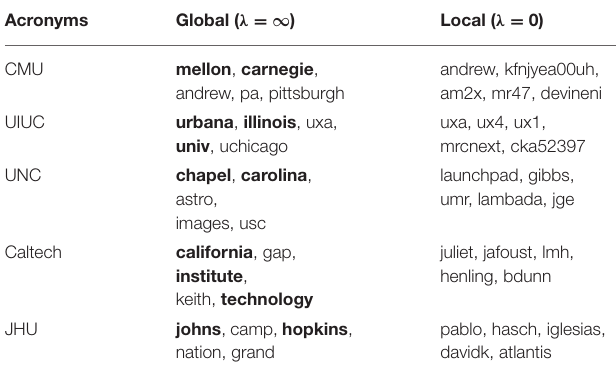
TABLE 6 | Effect of global context on interpreting